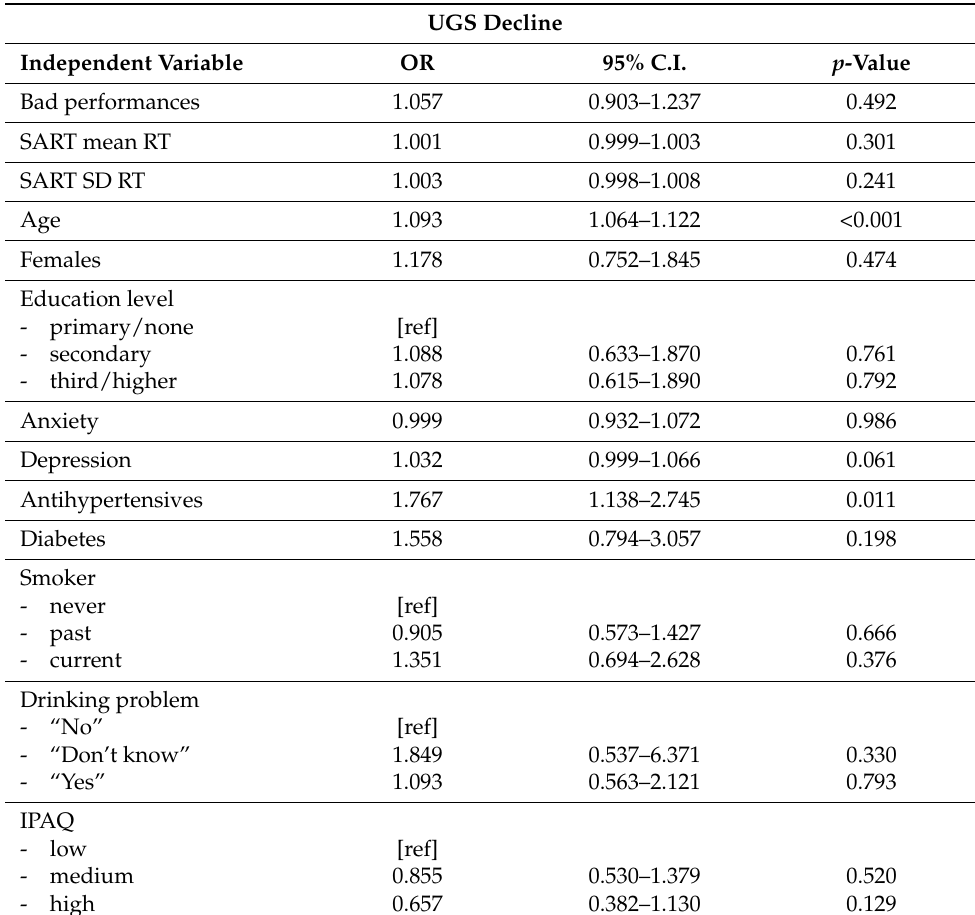
Table A3. Results for the fully adjusted per covariates binary logistic regression model 4 considering bad performances as potential predictor and having UGS decline as outcome.